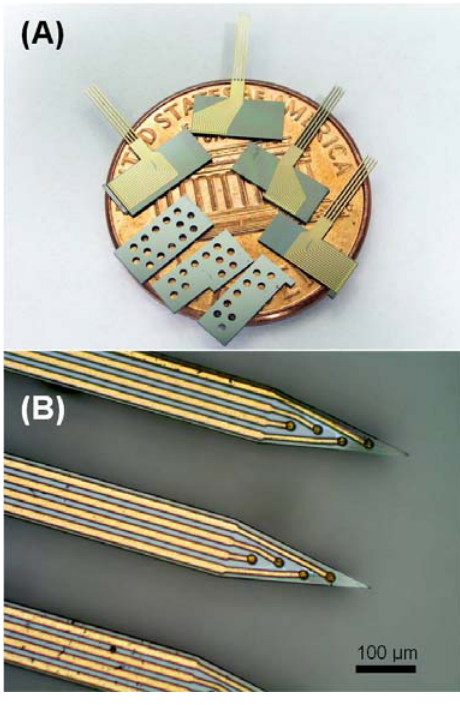
Figure 2. Microphotographs of fabricated 2-D arrays. (A) Fabricated parts on a one cent coin. (B) Probe tip and electrode sites. The tapered tip angle is about